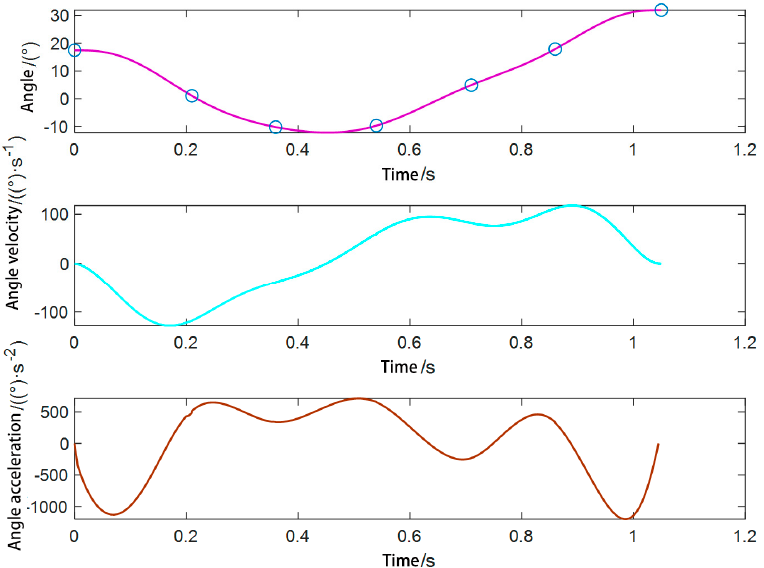
Figure 10. Plot of the angle, angle velocity, and angle acceleration of joint 2.